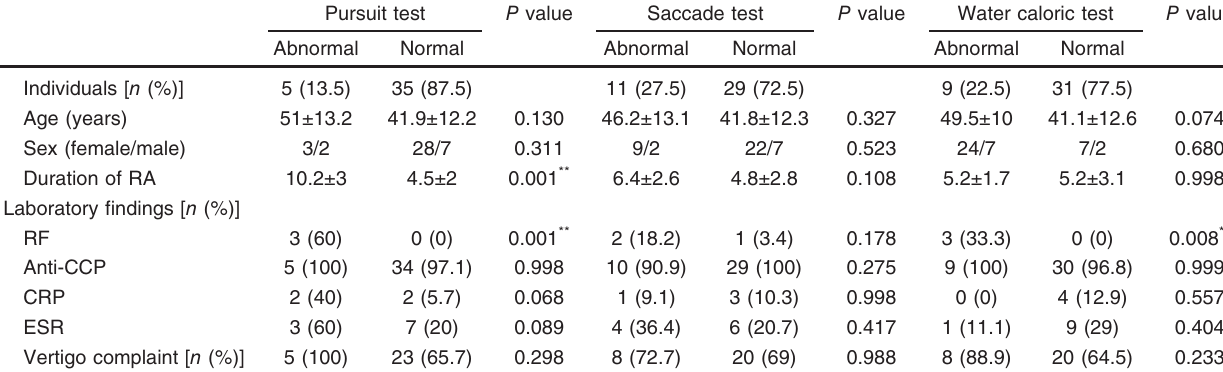
Table 4 Correlation between videonystagmography results and age, sex, duration of disease, vertigo complaint, laboratory findings, and vertigo complaint in rheumatoid arthritis